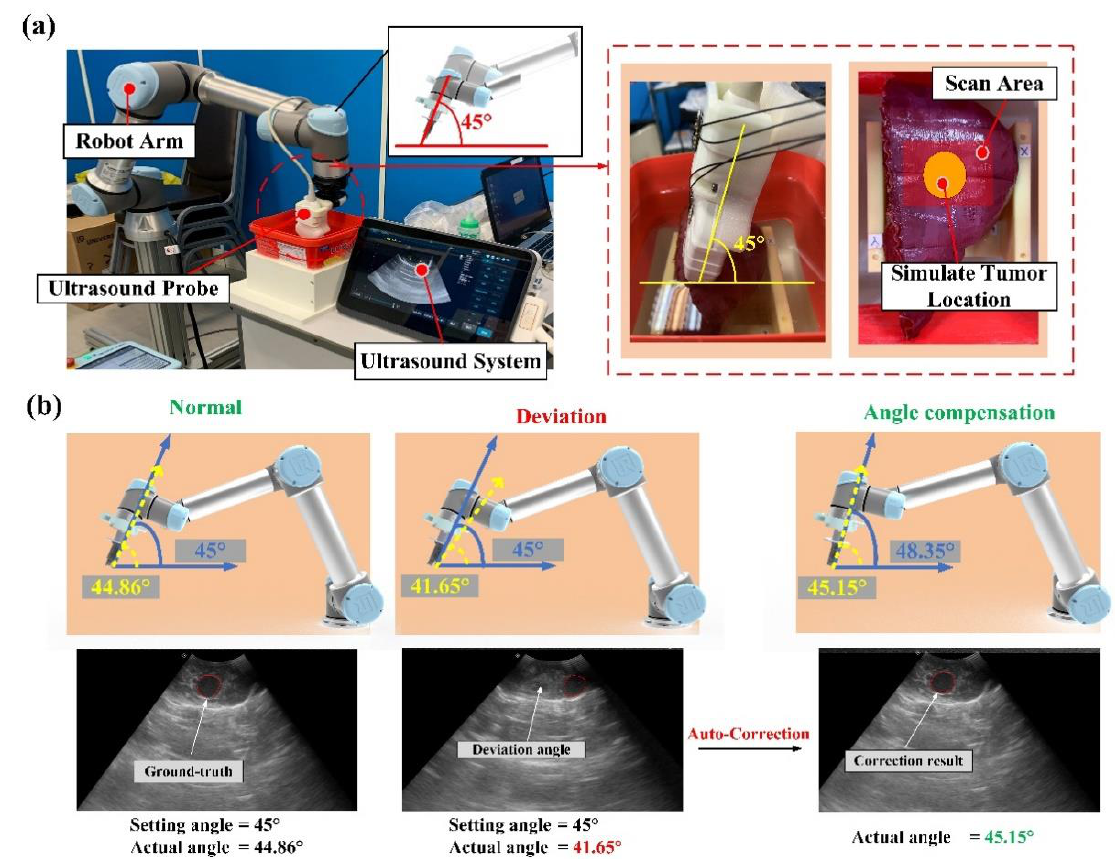
Figure 12. ( a ) Schematic diagram of the phantom test; ( b ) ultrasonic image test for a liver gel phantom model of the system.